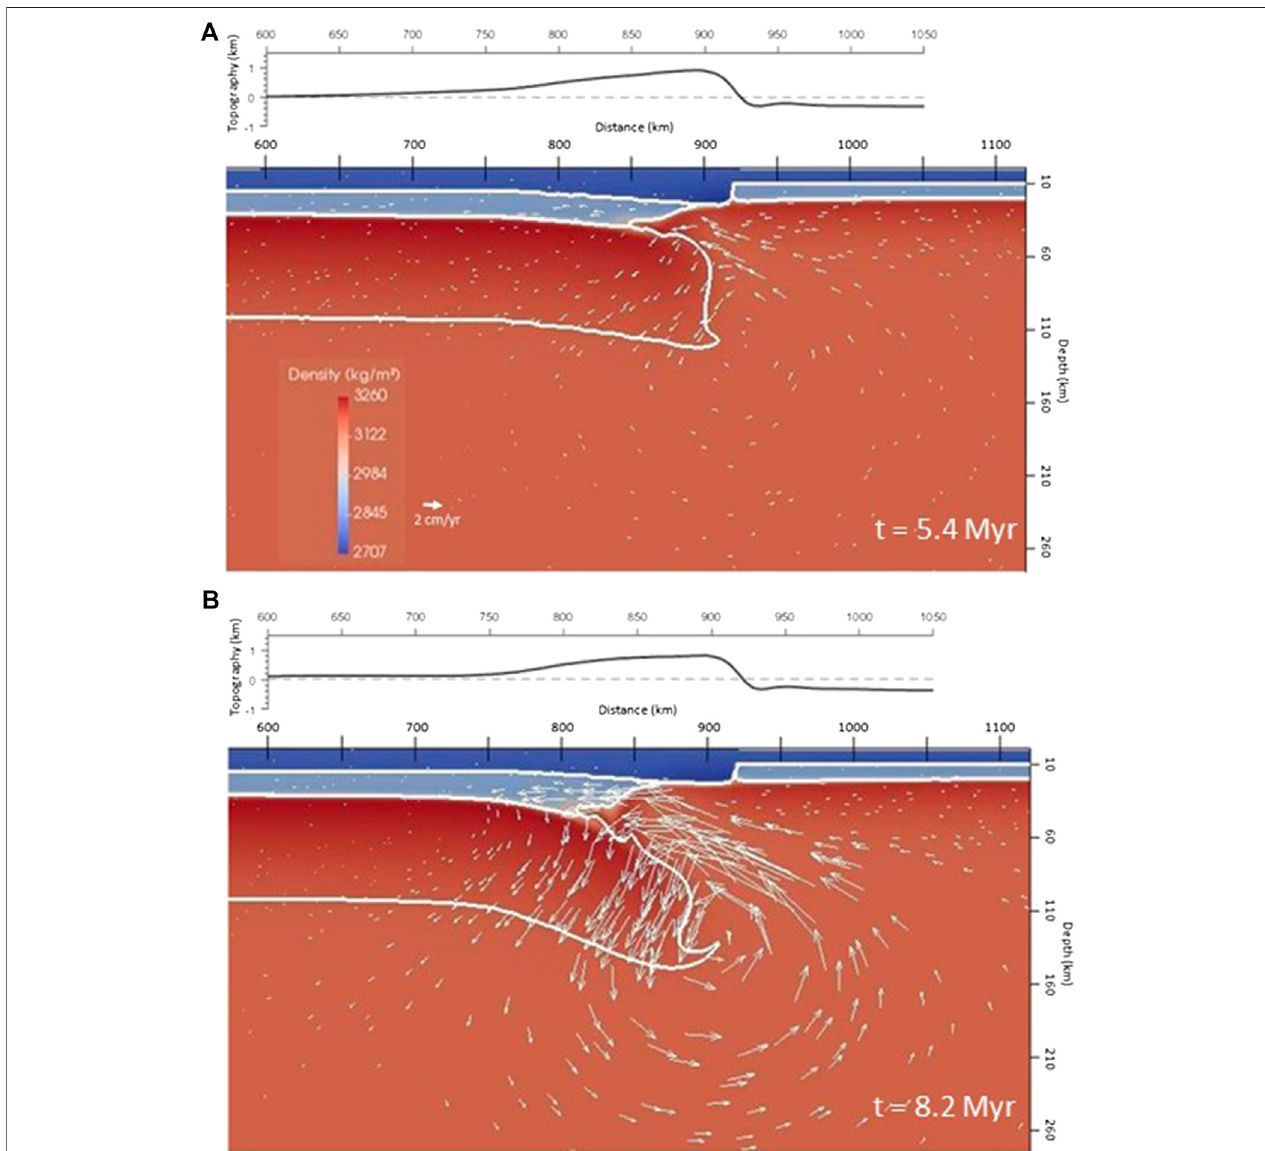
FIGURE 9 | Distribution of density and velocity fi eld and topographic response at different times (A) 5.4 Myr (for comparison purposes with the fi nal time of the Reference Model), (B) 8.2 Myr of the “ Slow Model. ”